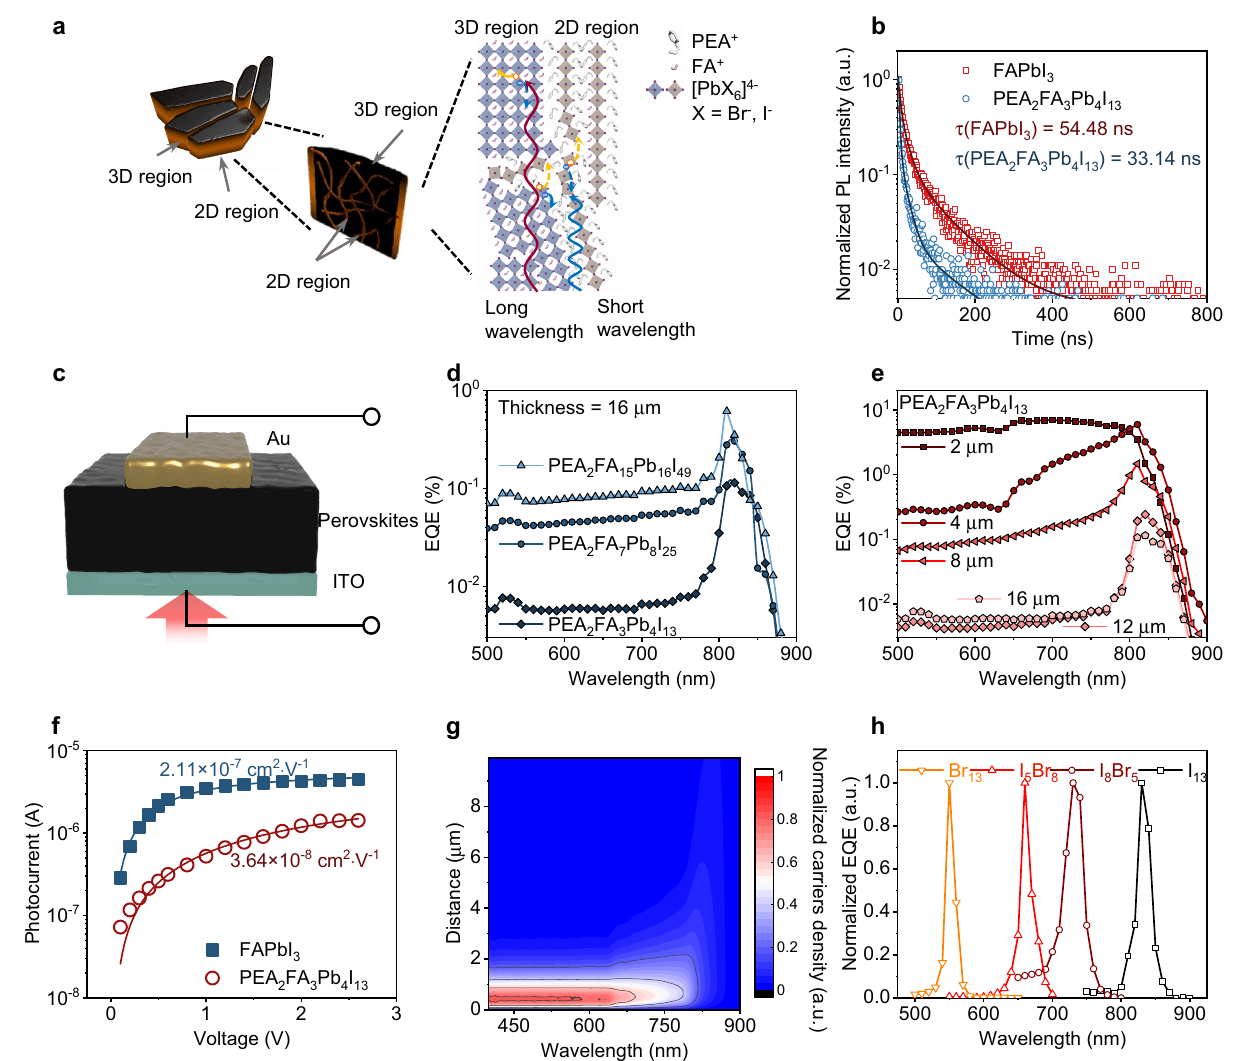
Fig. 3 | The charge carriers ’ transport in spray-coated thick fi lm and narrow- band photodetector. a Schematic diagram of the perovskites (PEA 2 FA n-1 Pb n X 3n+1 ) fi lmsfabricatedbyspray-coating. The recombination occursatthe grainboundary (2D region), selectively collecting long wavelength-generated carriers and narrow- band response. b The TRPL spectra of PEA 2 FA 3 Pb 4 I 13 ( τ =33.14ns) and FAPbI 3 ( τ =54.48ns) fabricated by spray-coating. c The device structure to analyze the in fl uent of narrow-band response photosensitive layer. d The EQE value of devices